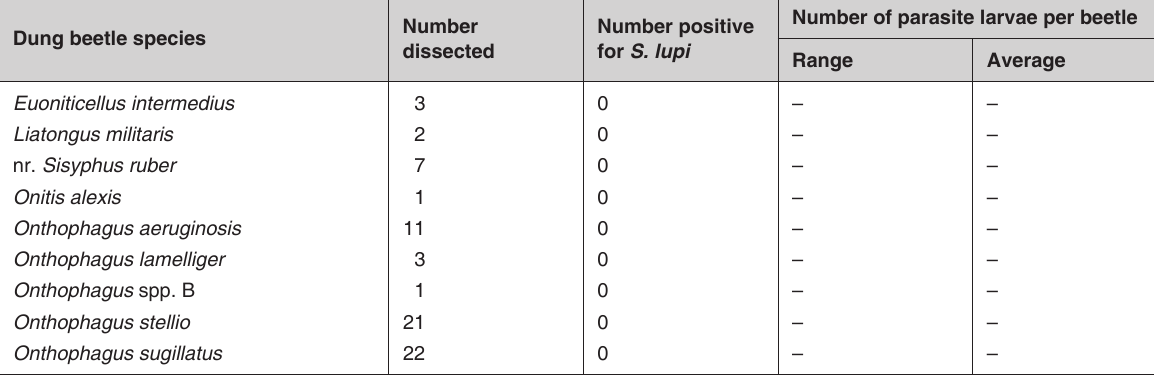
Dung beetle species